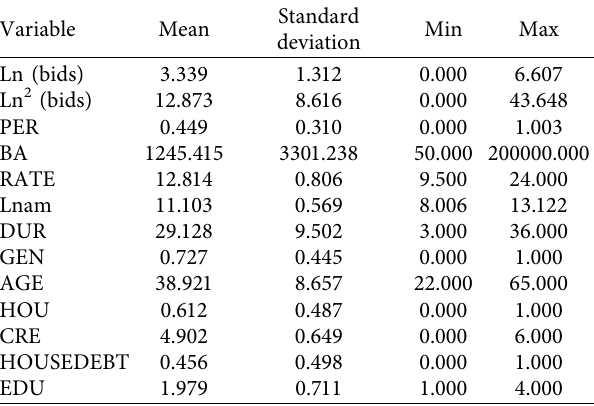
Table 2: Descriptive statistics of hypothesis 1 and hypothesis